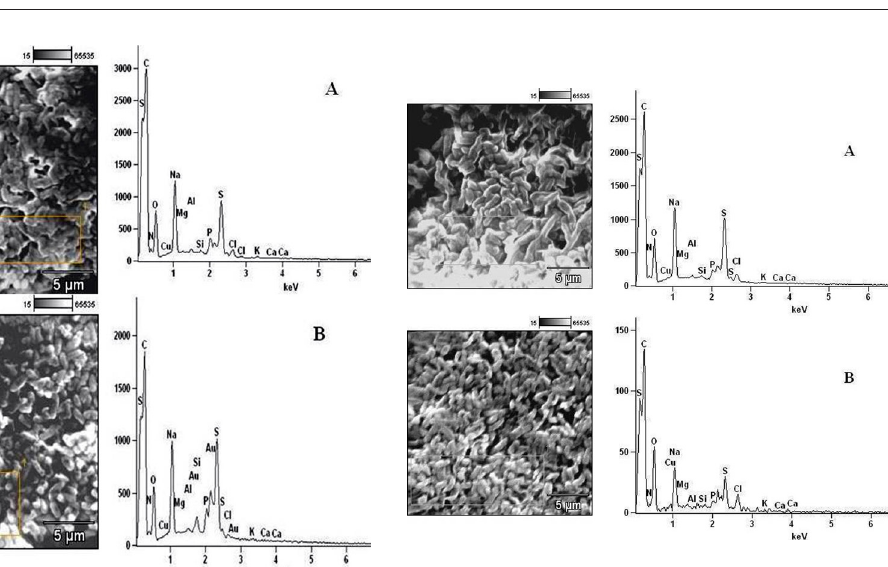
Fig. 6. Elemental components of (A) extract-untreated E. coli and (B) extract-treated E. coli .